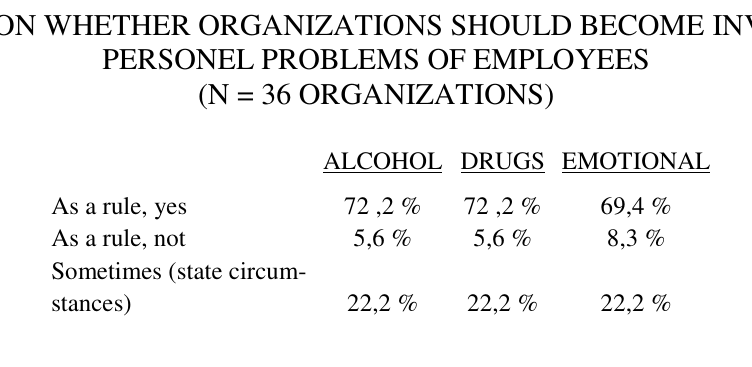
OPINIONS ON WHETHER ORGANIZATIONS SHOULD BECOME INVOLVED